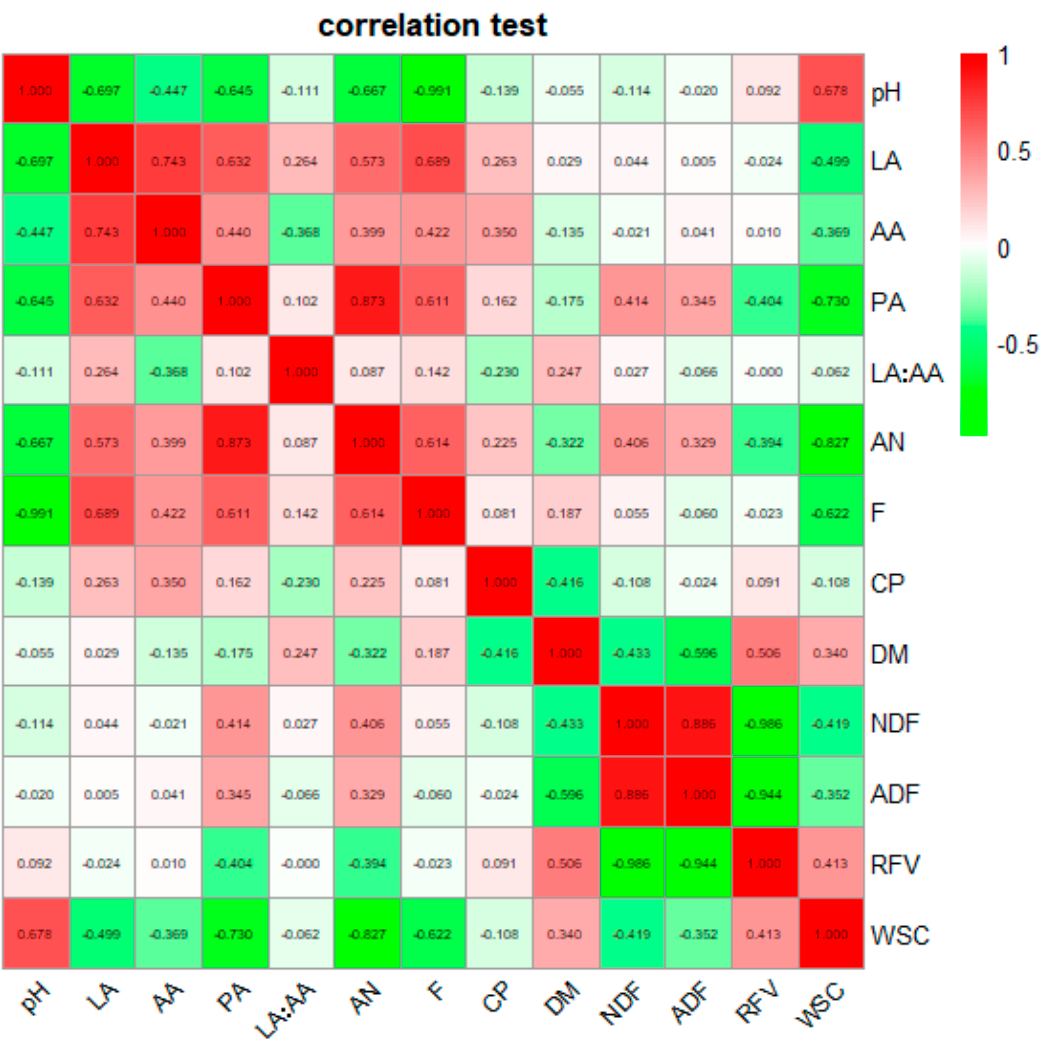
Figure 6. Pearson correlation between the fermentation and chemical indexes of alfalfa silages throughout the ensiling period. LA, lactic acid; AA, acetic acid; PA, propionic acid; LA:AA, lactic acid: acetic acid ratio; AN, ammonia nitrogen; F, Fleig’s point; CP, crude protein; DM, dry matter; NDF, neutral detergent fiber; ADF, acid detergent fiber; RFV, relative feed value; WSC, water-soluble carbohydrates. The number in each square represents the correlation extent; the color represents significant correlation ( p < 0.05), the deeper the color of the square is, the more significant the correlation. The red color means a positive correlation, and the green color means a negative correlation.